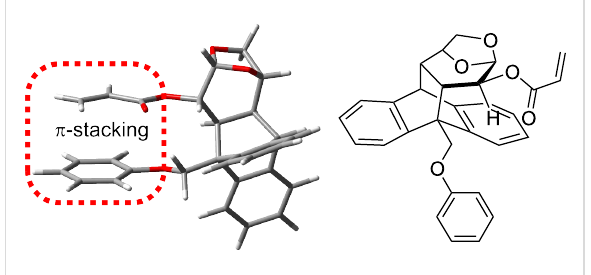
Figure 1: Intramolecular aryl–vinyl π -stacking interaction of a levoglu- cosenone derivative.